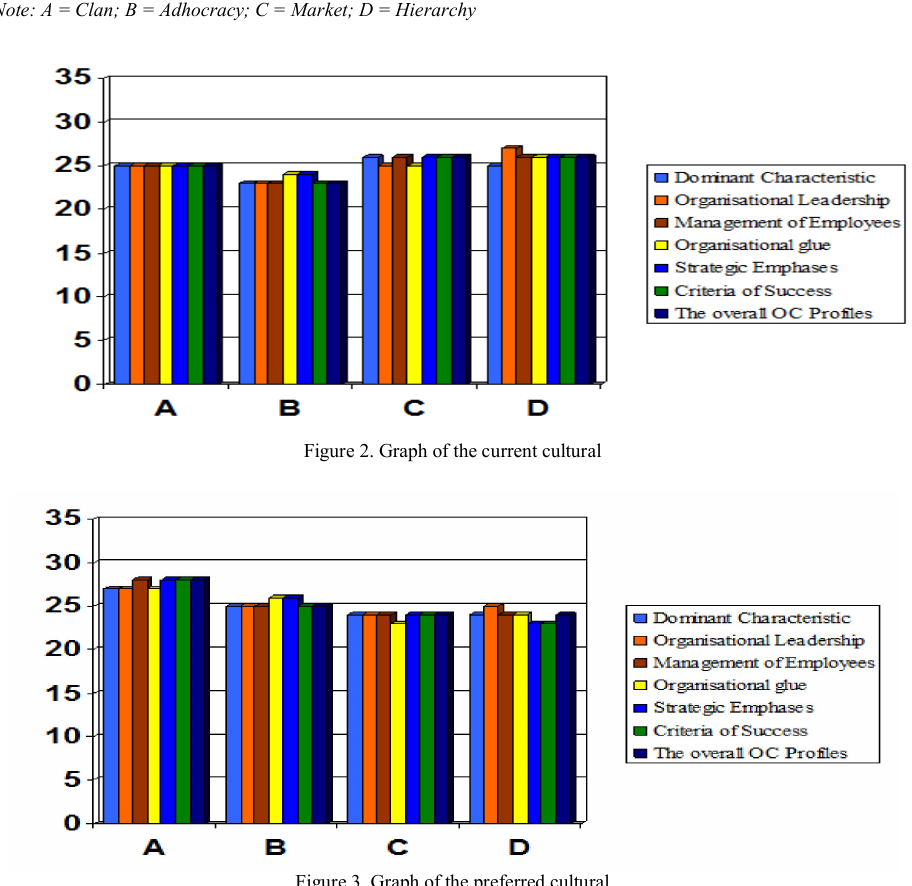
Figure 3. Graph of the preferred